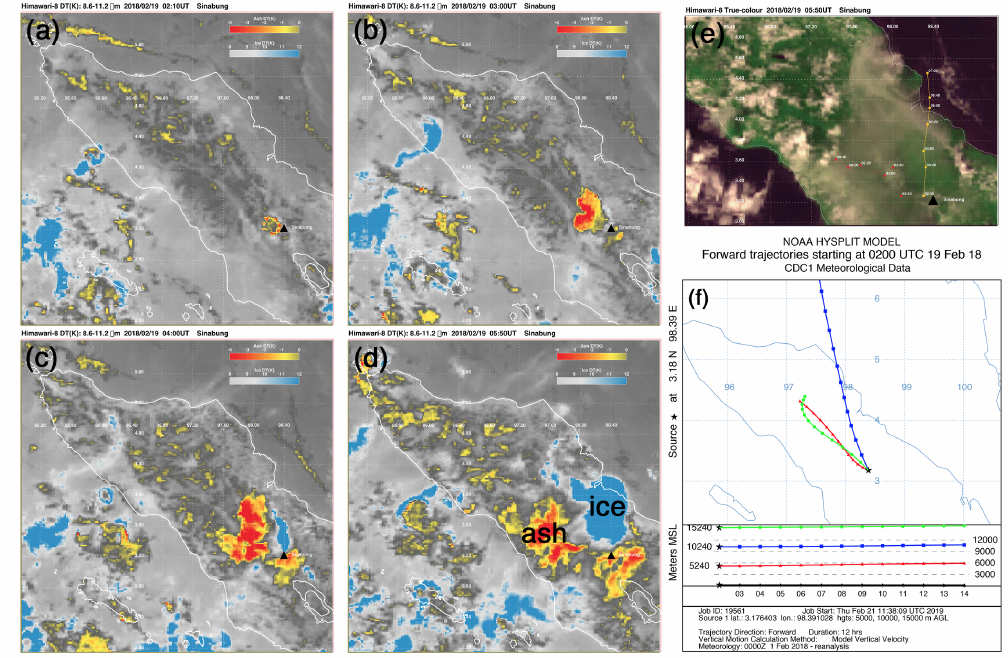
Figure 19. Temporal development of the Sinabung eruption cloud. ( a ) Ash signal appears as a ring around an opaque centre. ( b ) Ash cloud grows. ( c ) Ice appears on the eastern edge of the eruption cloud. ( d ) Ice-rich and ash-rich portions separate. ( e ) Trajectories of the most negative (ash) and most positive (ice) brightness temperature pixels at different times. ( f ) HYSPLIT dispersion model trajectories for emissions starting at three different